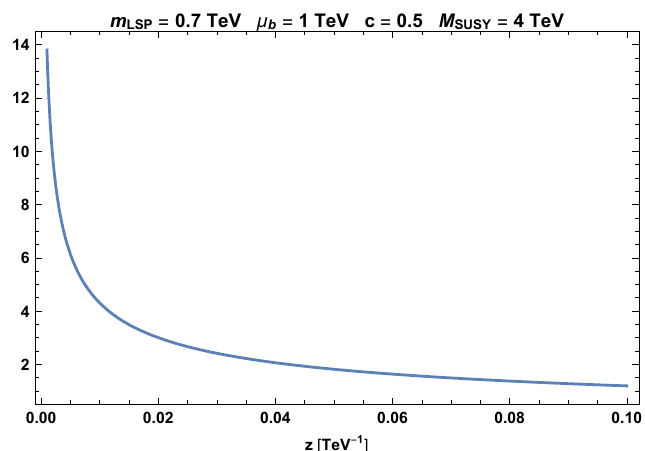
Figure 1. A normalized zero mode pro(cid:12)le with M 0